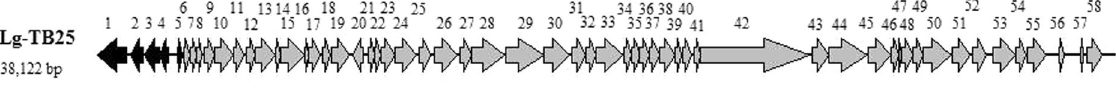
Figure 2. Map of the phage PLg-TB25 genome. Each arrow and number identifies an open reading frame. Black arrows identify the lysogeny module. For specific functions see Table 1.